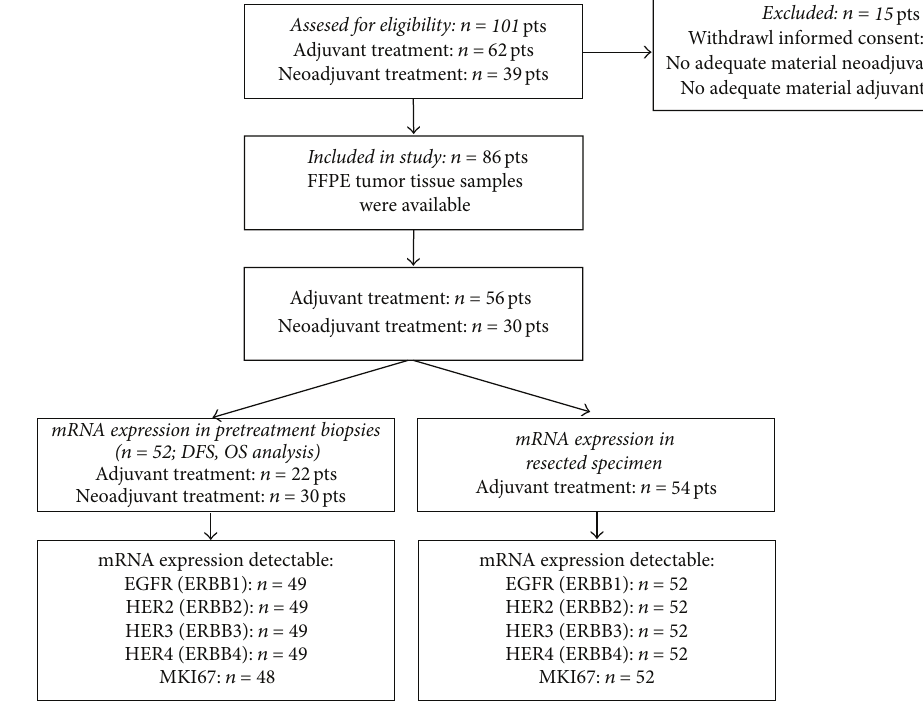
Figure 1: Participants and samples flow chart diagram.